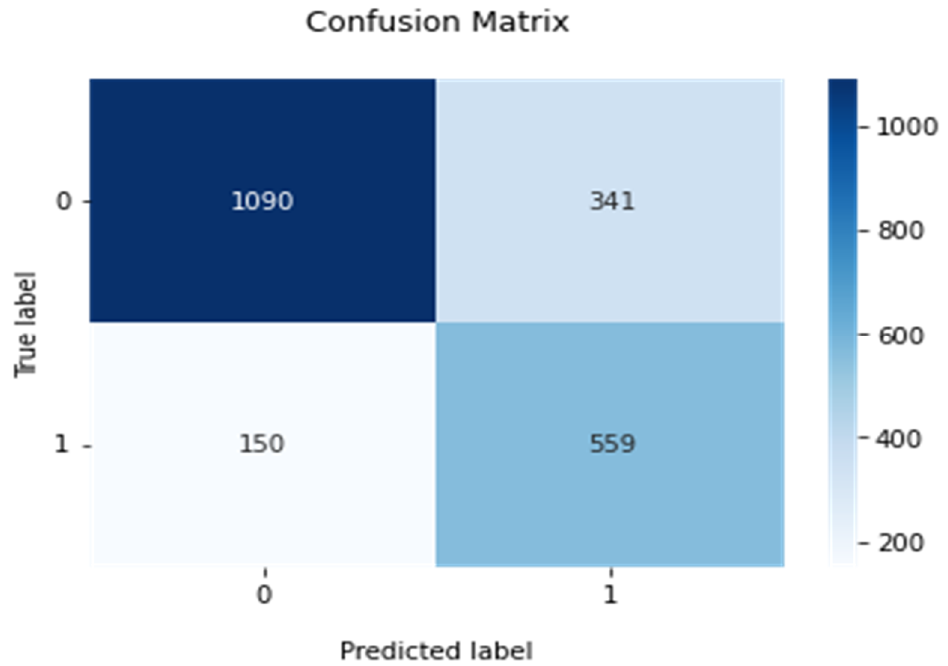
Figure 9. A combined confusion matrix of applying five trained models to five independent testing data subsets with total 2140 cases of the ResNet50 model optimized with CBAM (representing lesion classification result on the pooling testing data). In labeling axes of the confusion matrix, “1” represents a malignant lesion class, while “0” represents a benign lesion class.